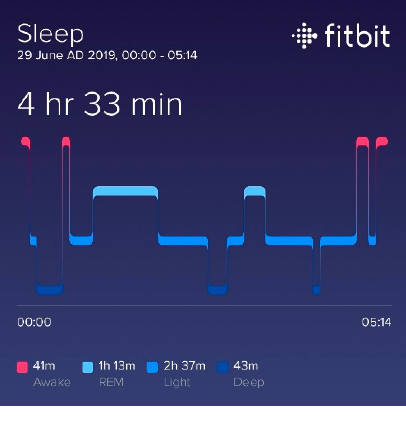
Figure A7. Nagoya, Japan.